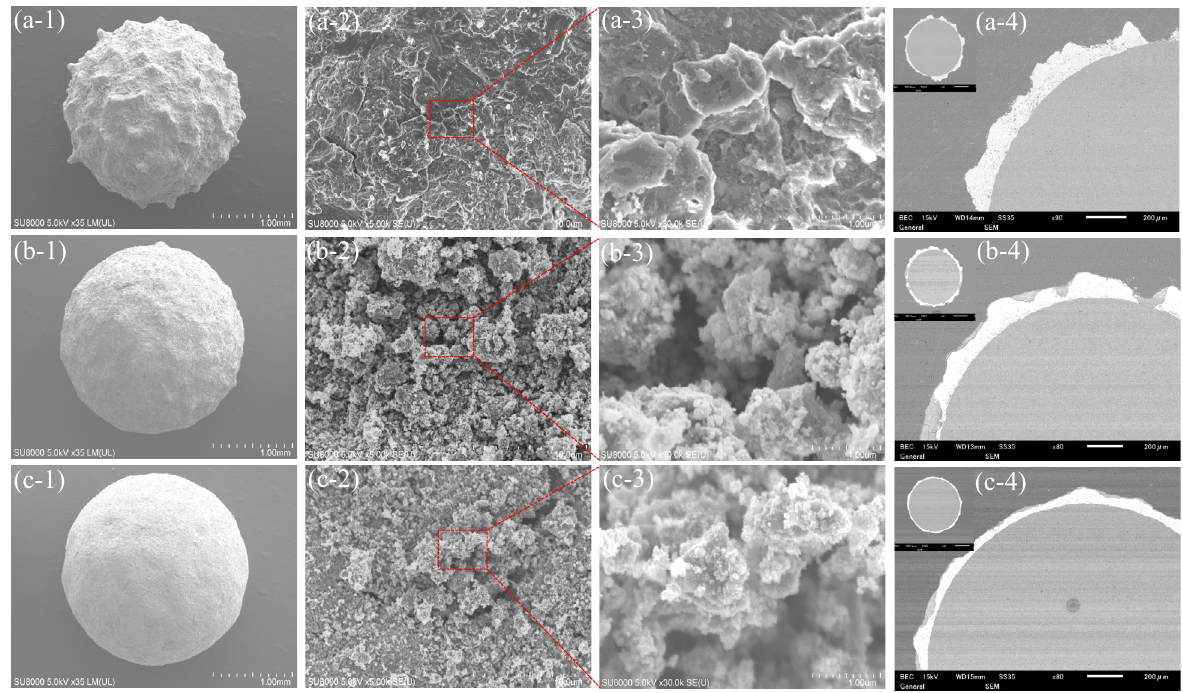
Figure 1. SEM microstructures of the surfaces and cross sections of the samples. ( a ) Ti, ( b ) TiO 2 /Ti, and ( c ) TiO 2